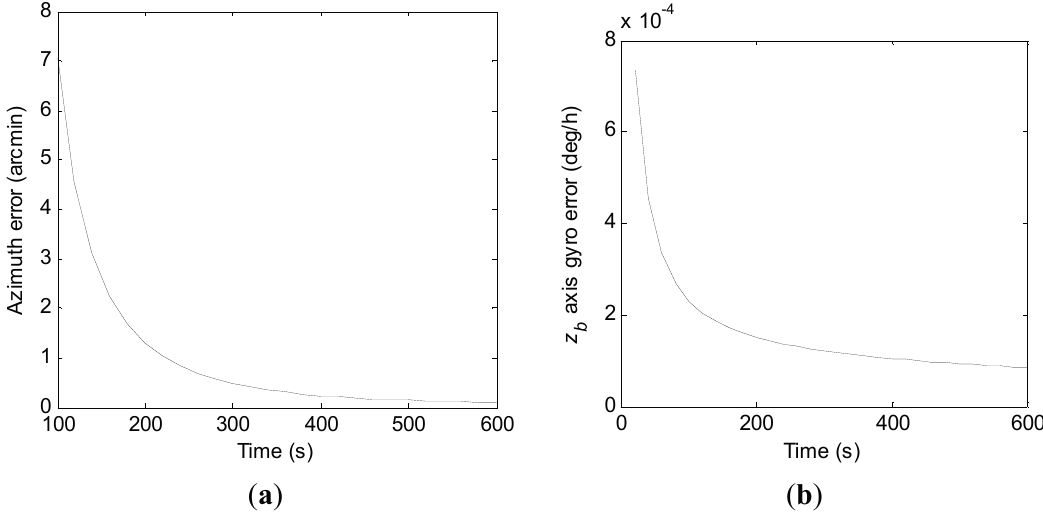
Figure 10. Convergence curves of the azimuth error and the z b axis gyro error within 600 s by the conventional KF scheme in practical application. ( a ) Azimuth error; ( b ) z b axis gyro erro.